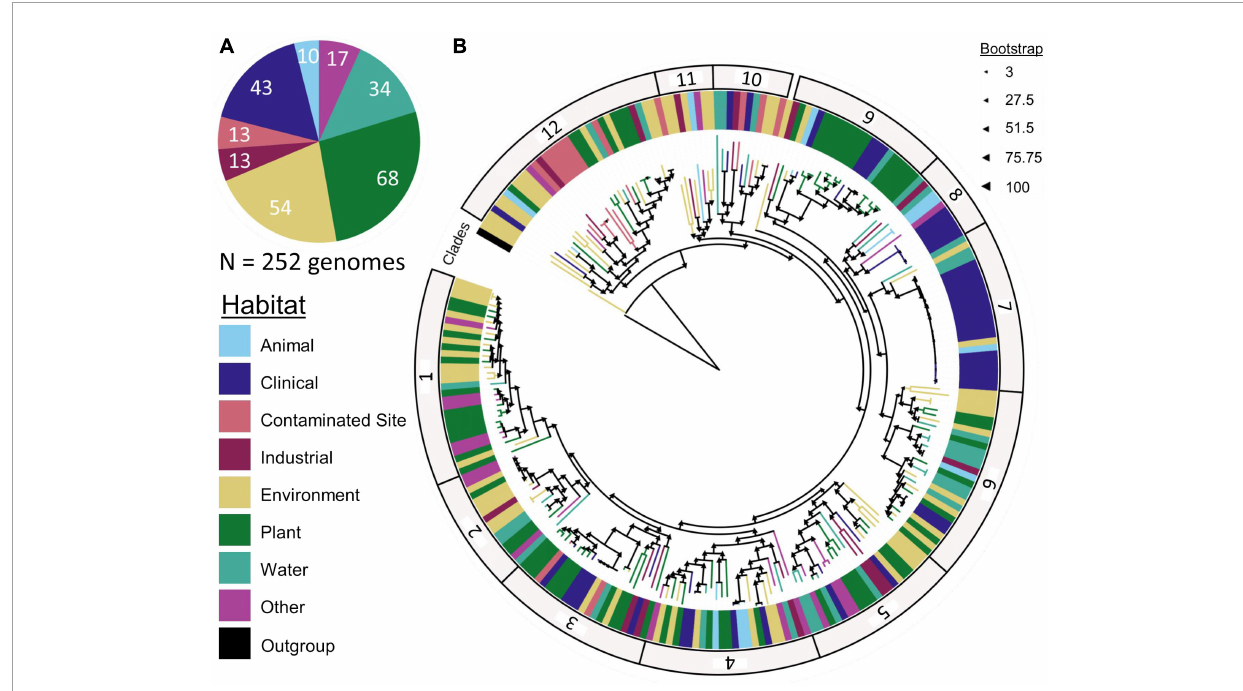
FIGURE3 Sphingomonas (A) habitat and (B) phylogenetic tree constructed with 252 Sphingomonas genomes and 404 core genes, separated into 12 clades. The closely related Rhodospirillum centenum SW was used as the outgroup to identify the core gene alignment and construct the tree. Significant ( p < 0.05) ANOSIM results indicate that Sphingomonas habitat preferences vary across